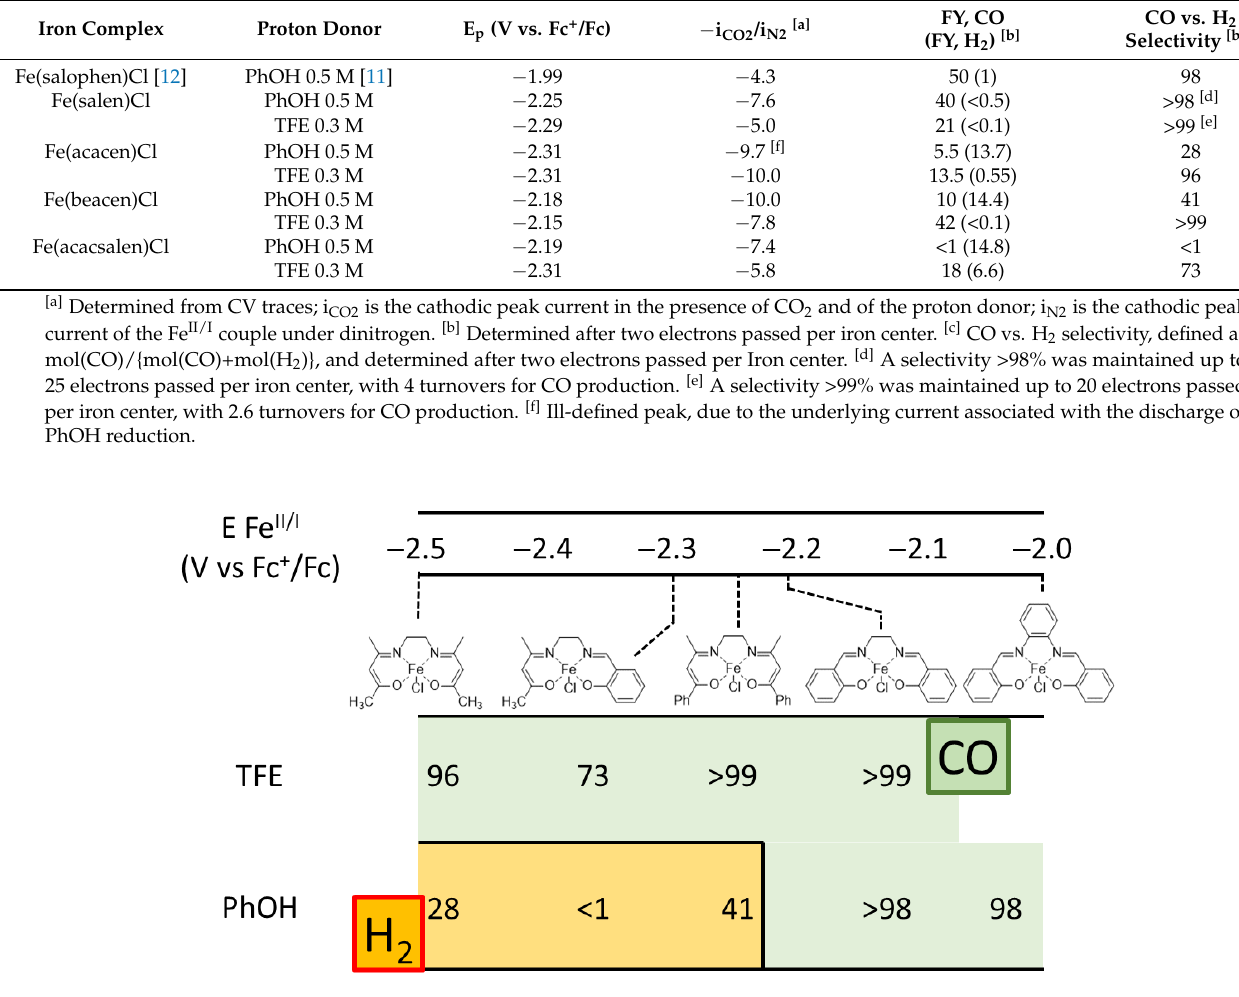
Figure 6. CO vs. H 2 selectivity in CPE experiments with Iron complexes, depending on the proton donor. The selectivity was compared after the same charged passed, in particular at two electrons per iron catalyst (see Table 2), and used as performance indicators in the series.